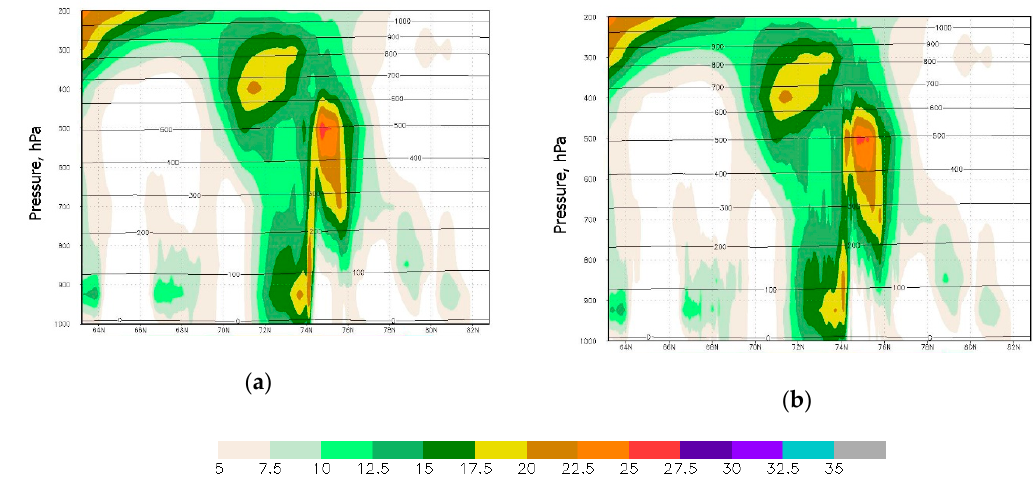
Figure 11. ICON-A6.5 ( a ) and ICON-A2 ( b ). Vertical profiles of the 10 m wind speed along 38.5 ◦ E. Valid time 04:00 Figure 11. ICON ‐ A6.5 ( a ) and ICON ‐ A2 ( b ). Vertical profiles of the 10 m wind speed along 38.5° E. Valid time 04:00 UTC